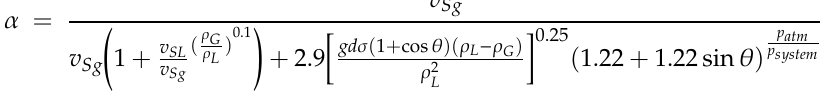
Figure 5. Composite correlation for slug flow [17].